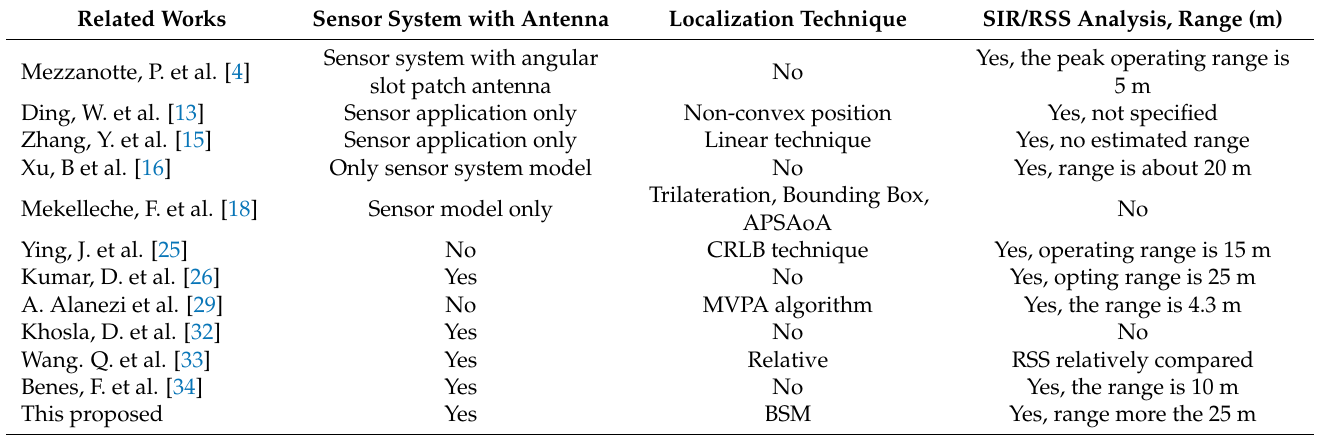
Table 7. Comparisons with some published